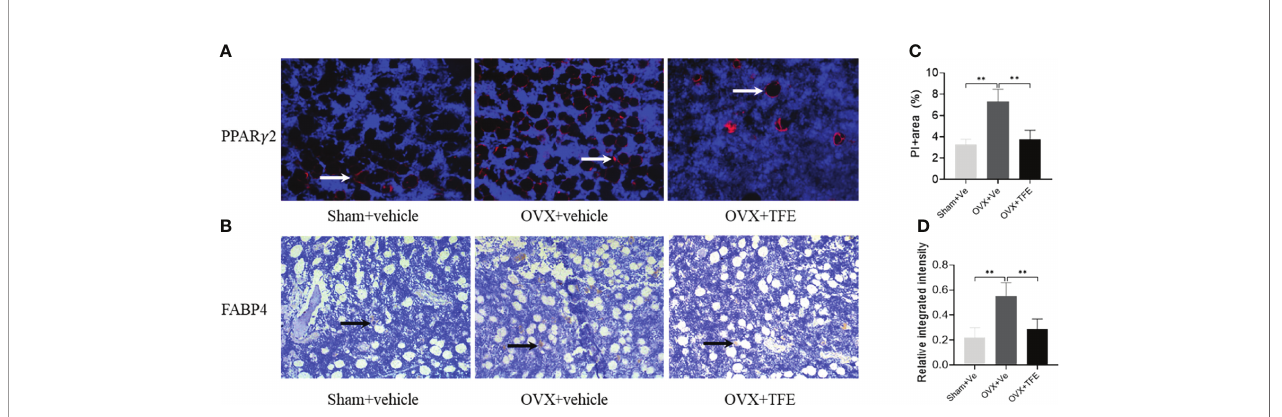
FIGURE 8 | Representative microscopic features of PPAR g 2 and FABP4 expression in bone marrow (200x magni fi cation). Quanti fi cation of PPAR g 2 expression by immuno fl uorescence (A) and FABP4 expression by immunohistochemistry (B) in the bone marrow showed a signi fi cant increase in PPAR g 2 and FABP4 protein expression in proximal tibiae of OVX rats, which were restored to normal levels after TFE treatment. For PPAR g 2, the positively staining pixels were presented as a percentage of the total pixels (C) ; for FABP4, semi-quanti fi cation is expressed as the relative integrated intensity of intramarrow staining (D) . FABP4, fatty acid-binding protein 4; PPAR g 2, peroxisome proliferator-activated receptor gamma-2; OVX, ovariectomy; Sham, sham-operation; TFE, total fl avonoids of Epimedium; Ve, vehicle. Data are shown as mean ± SD (Sham, n = 11; OVX, n = 10; TFE, n = 11). ** P <0.001 between groups analyzed by One- way ANOVA with